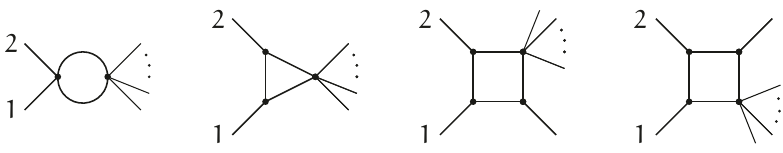
Figure 3 . Scalar one-loop functions contributing to the limit when 1 and 2 become